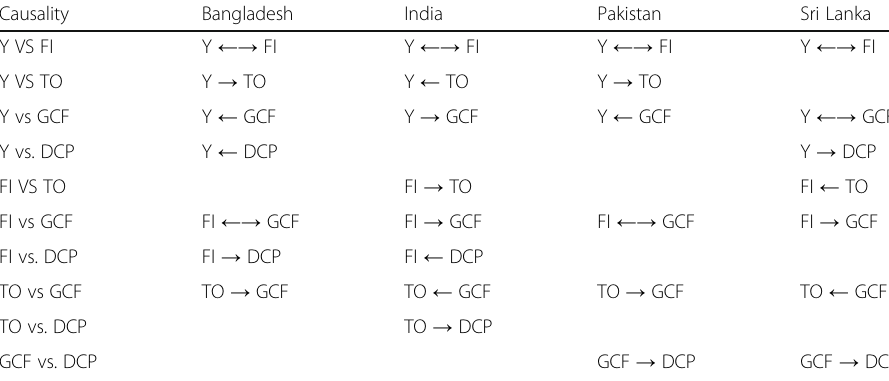
Table 7 Summary of Short-run causality Causality Bangladesh